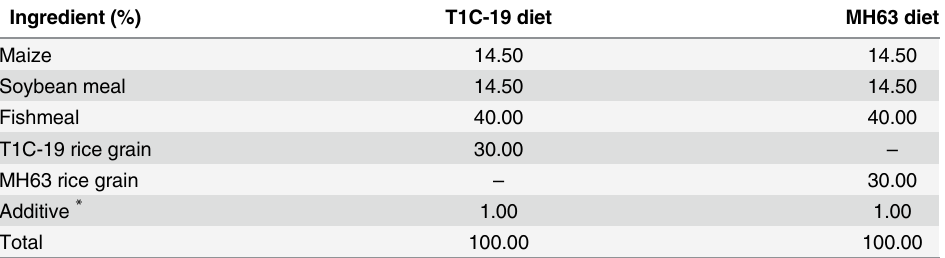
* Contains in mg kg – 1 diet: iron, 70; copper, 11; manganese, 70; zinc, 65; iodine, 0.49; selenium, 0.3; vitamin A, 8000 (IU); vitamin D, 2400 (IU); vitamin E, 20 (IU); vitamin K, 0.5 (IU); vitamin B1, 2; vitamin B2,